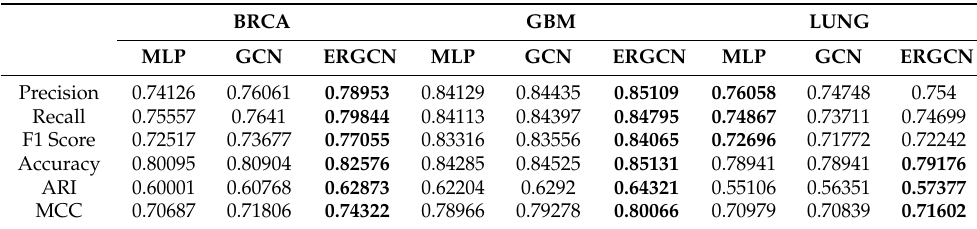
Table 8. The experiment results for the ablation